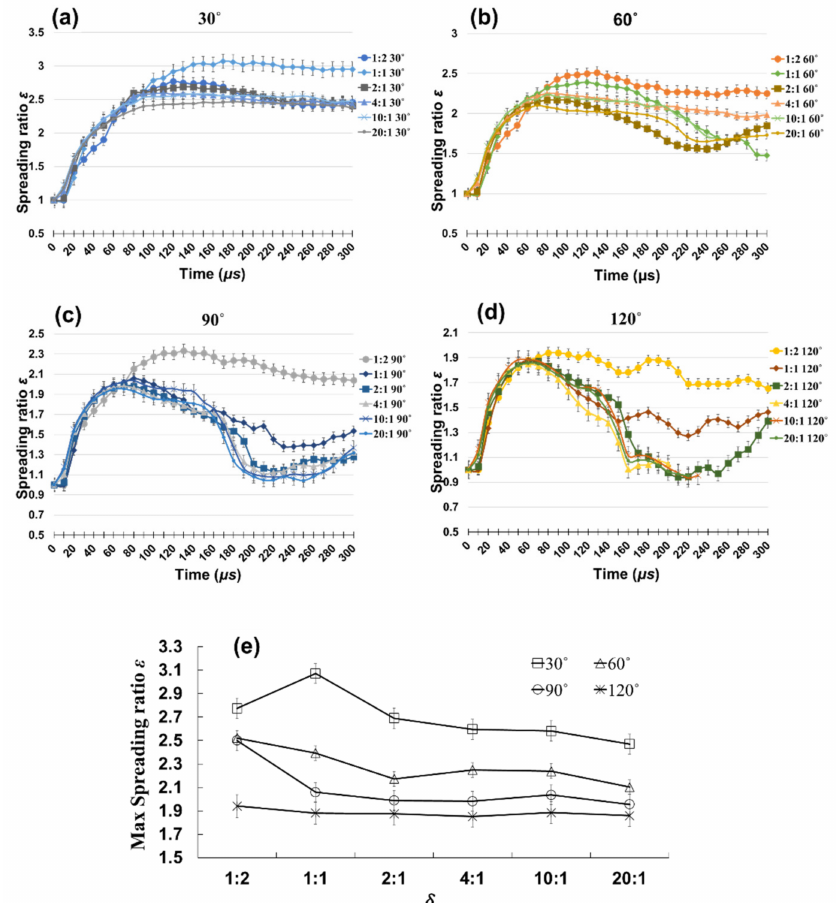
Figure 8. ( a – d ) shows the temporal evolution of the droplet spreading ratios with different particle sizes. ( e ) summarizes the relationship between particle sizes with the maximum spreading